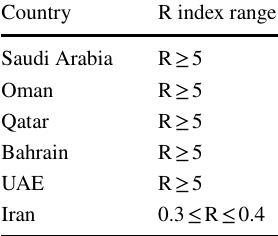
Table 1 R index on the priority of Middle Eastern countries for using solar energy for fresh water production, based on defined indicators (Pugsley et al.